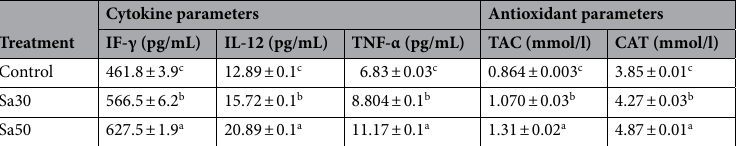
Table 3. Interferon-gamma (IF-γ), interleukin-12 (IL-12), tumor necrosis factor-alpha (TNF-α), and total antioxidant capacity (TAC) levels and catalase activity of the groups fed Nigella sativa seeds (30 g/kg and 50 g/ kg) and the control group. The data are presented as the means ± SEs, n = 6 per group. Means within the same column with different superscript letters are significantly ( P < 0.05) different according to one-way ANOVA followed by Duncan’s post hoc analysis . Sa30: group fed Nigella sativa at 30 g/kg diet; Sa50: group fed Nigella sativa at 30 g/kg